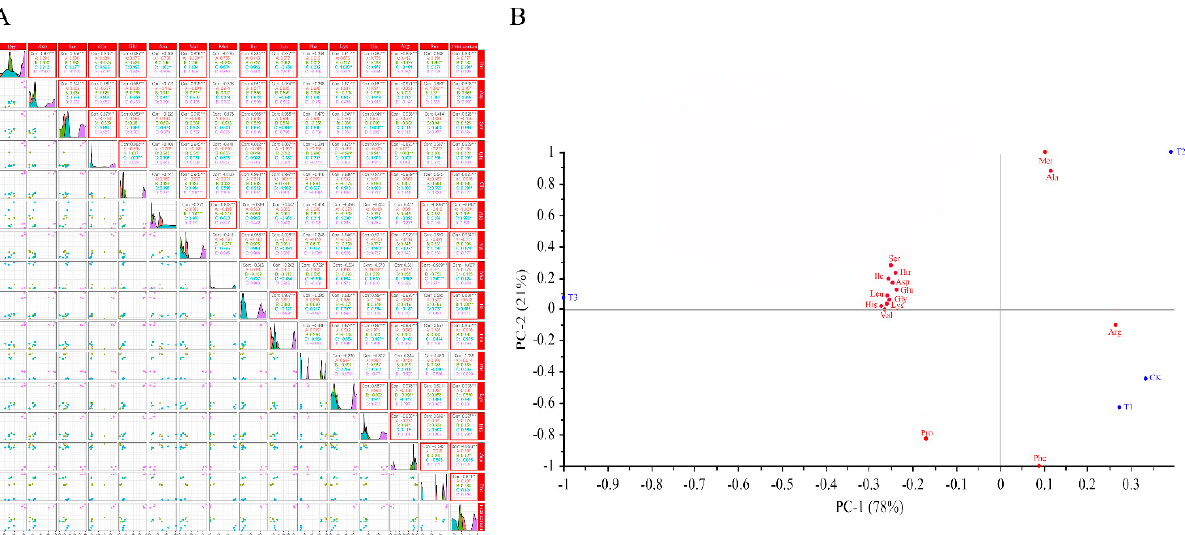
Figure 4. ( A ) Correlation analysis of the contents of amino acids in ‘Cabernet Gernischt’ ( Vitis vinifera L.) with different treatments. The amino acids with relevant significance were marked in the red box ( p ≤ 0.05). ( B ) 15 amino acids on PC1 vs. PC2 by bi-plot (scores plot and loadings plot).